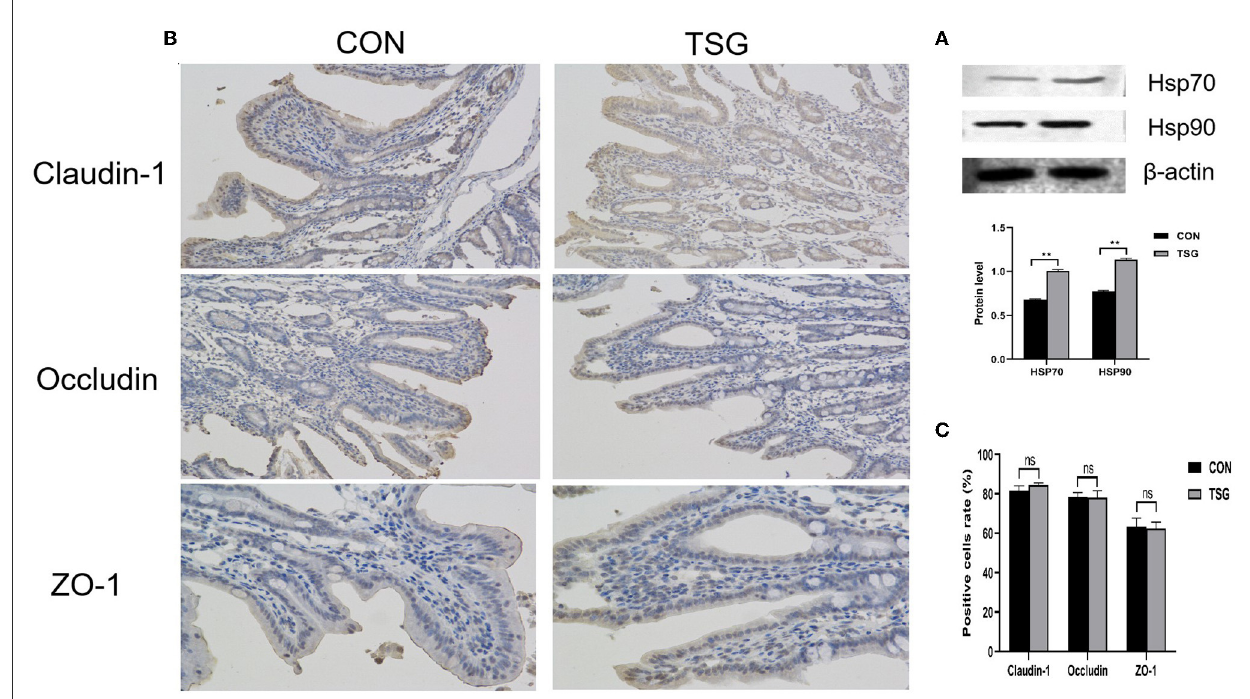
FIGURE1 The results of western blot and immunohistochemistry. (A) Showed that the relative expression levels of HSP70 and HSP90 proteins increased significantly after transportation (HSP 70, ** P < 0.01; HSP 90, ** P < 0.01). (B) was the result of immunohistochemical staining of jejunum tight junction protein, and the positive signal was reddish brown. (C) Showed the proportion of tight junction protein (Claudin-1, Occludin, ZO-1) positive cells, and the ns represented that there was no significant difference between transport group and stress group.